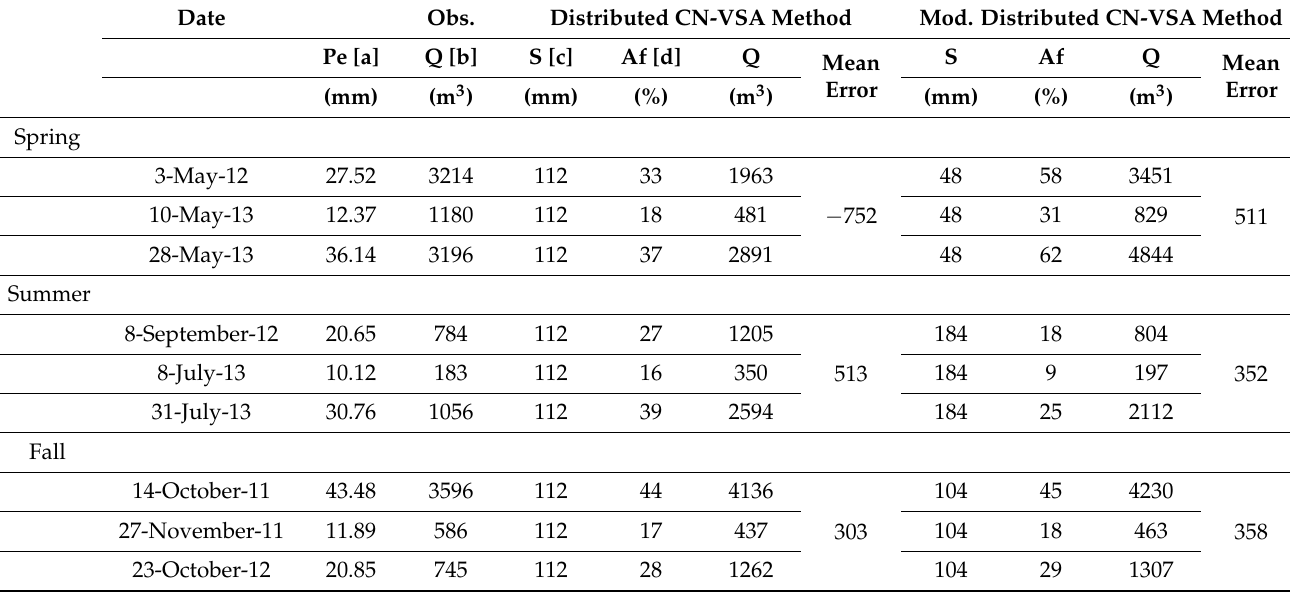
Table 1. Comparison of the runoff simulated by distributed CN-VSA method and modified distributed CN-VSA method with observed runoff. Obs. Distributed CN-VSA Method Mod. Distributed CN-VSA